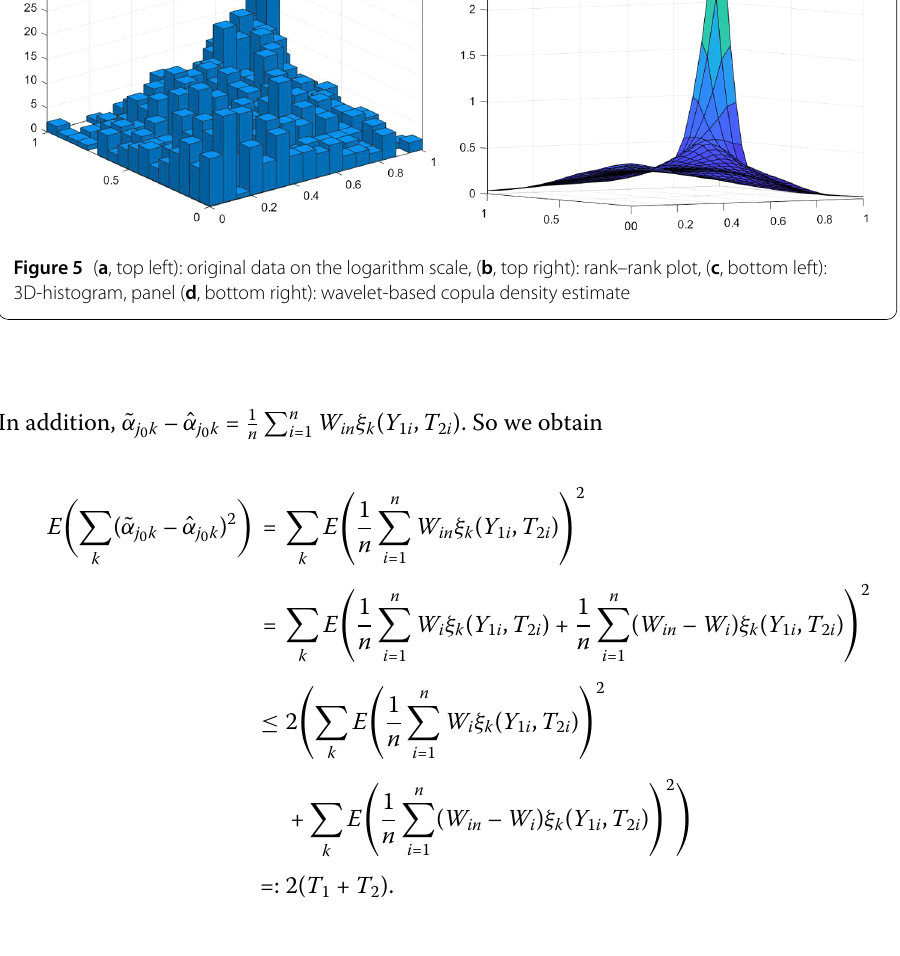
Figure 5 ( a , top left): original data on the logarithm scale, ( b , top right): rank–rank plot, ( c , bottom left): 3D-histogram, panel ( d , bottom right): wavelet-based copula density estimate